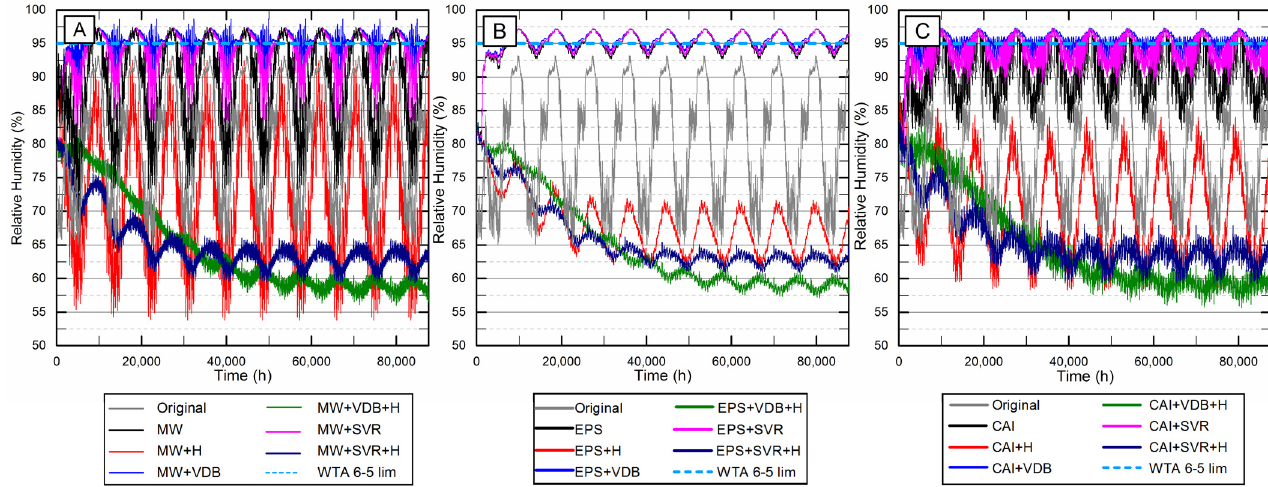
Figure 9. Relative humidity profiles behind the insulation surface: ( A ) Mineral Wool (MW), ( B ) EPS, and ( C ) Capillary Active Insulation (CAI).